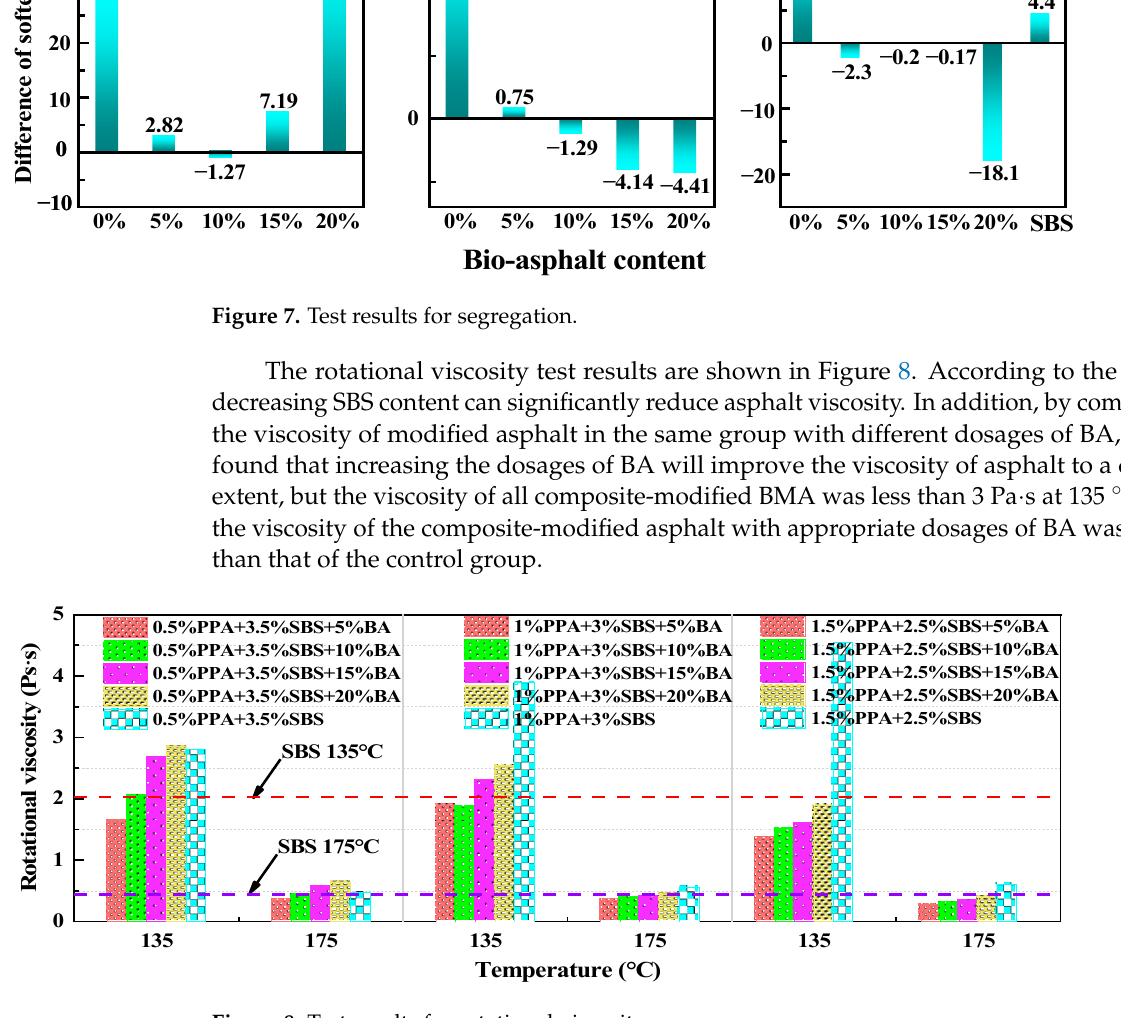
Figure 8. Test results for rotational viscosity.